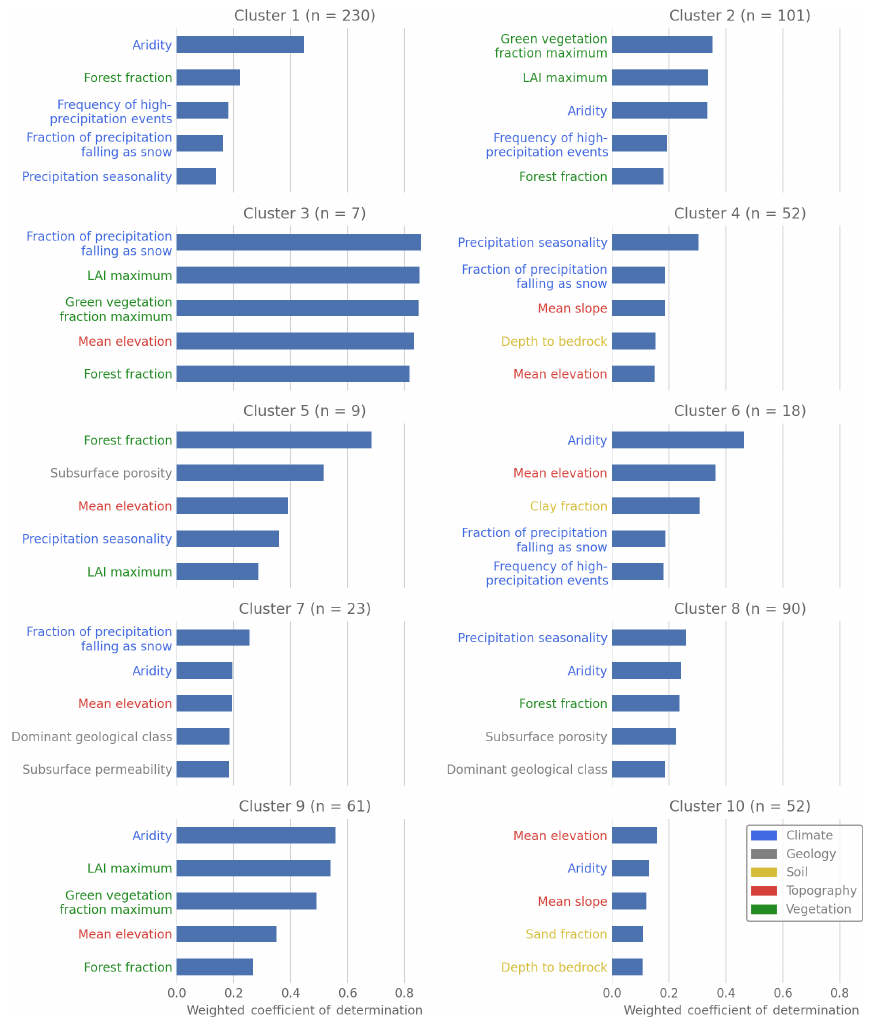
Figure 9. Importance of the catchment attributes evaluated by the quadratic regression for the catchment clusters. Attributes colored according to their catchment attribute